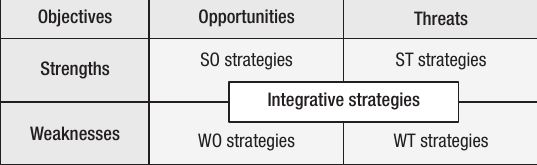
Fig. 12. Proposed modifi cations on SWOT